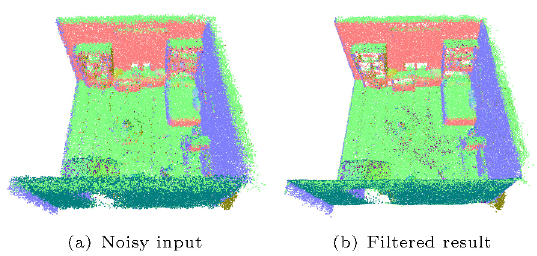
Fig. 22 Filtered result on noisy point cloud of an indoor scene.